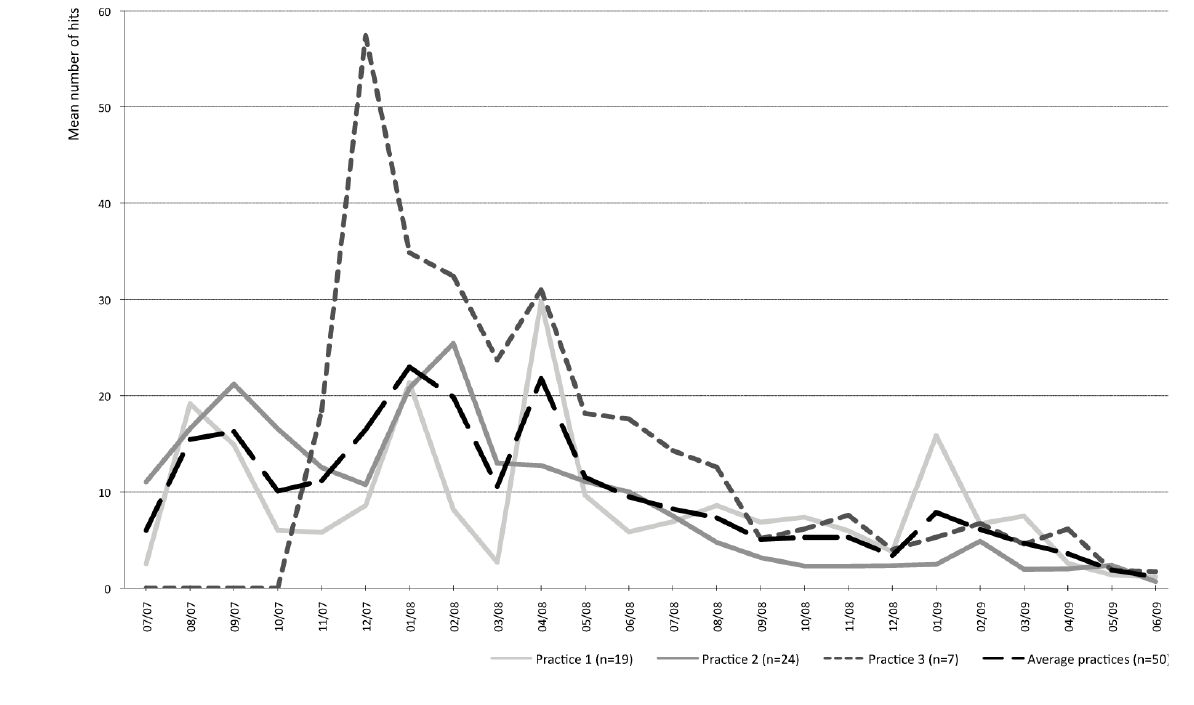
Figure 2. Long-term use of the web application by patients per practice.